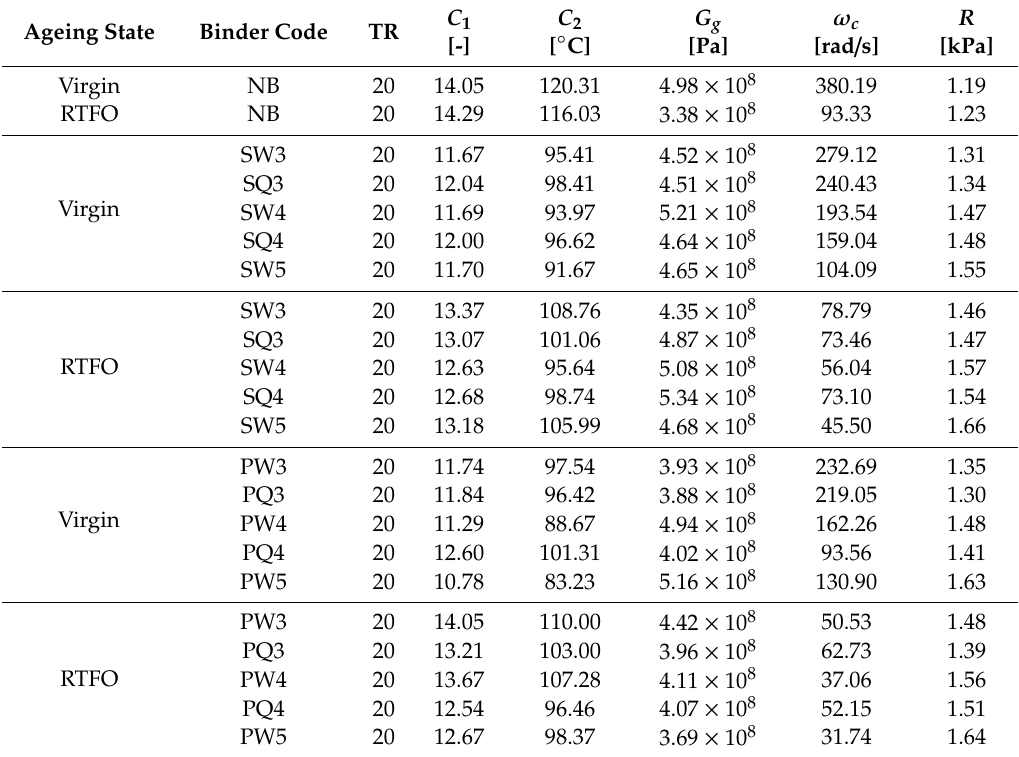
Table 5. Master curve